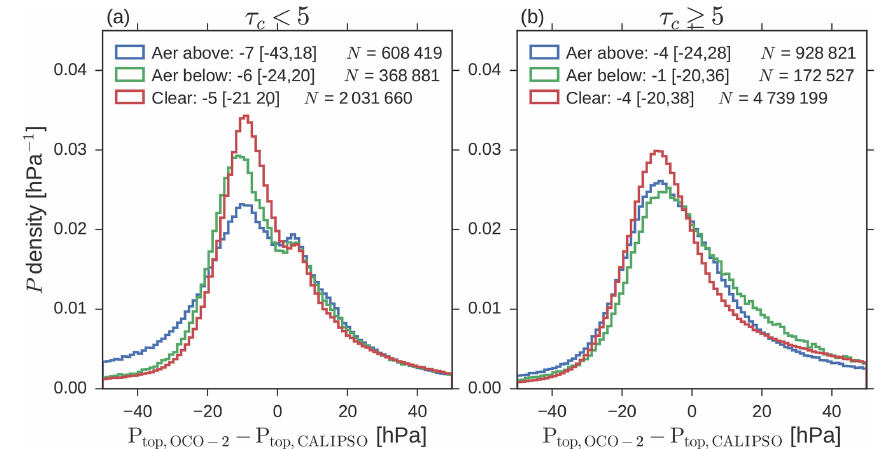
Figure 8. OCO-2 minus CALIPSO P top statistics for Quality_flag = 0 cases, subset for aerosol layer above cloud ( N ∼ 1 . 5 × 10 6 ), aerosol layer below cloud ( N ∼ 0 . 5 × 10 6 ) or no aerosol layer detected ( N ∼ 6 . 8 × 10 6 ) by CALIPSO’s 05kmALay. Legend reports median [14th, 18th percentiles]. (a) Clouds with posterior τ< 5. (b) Clouds with posterior τ ≥